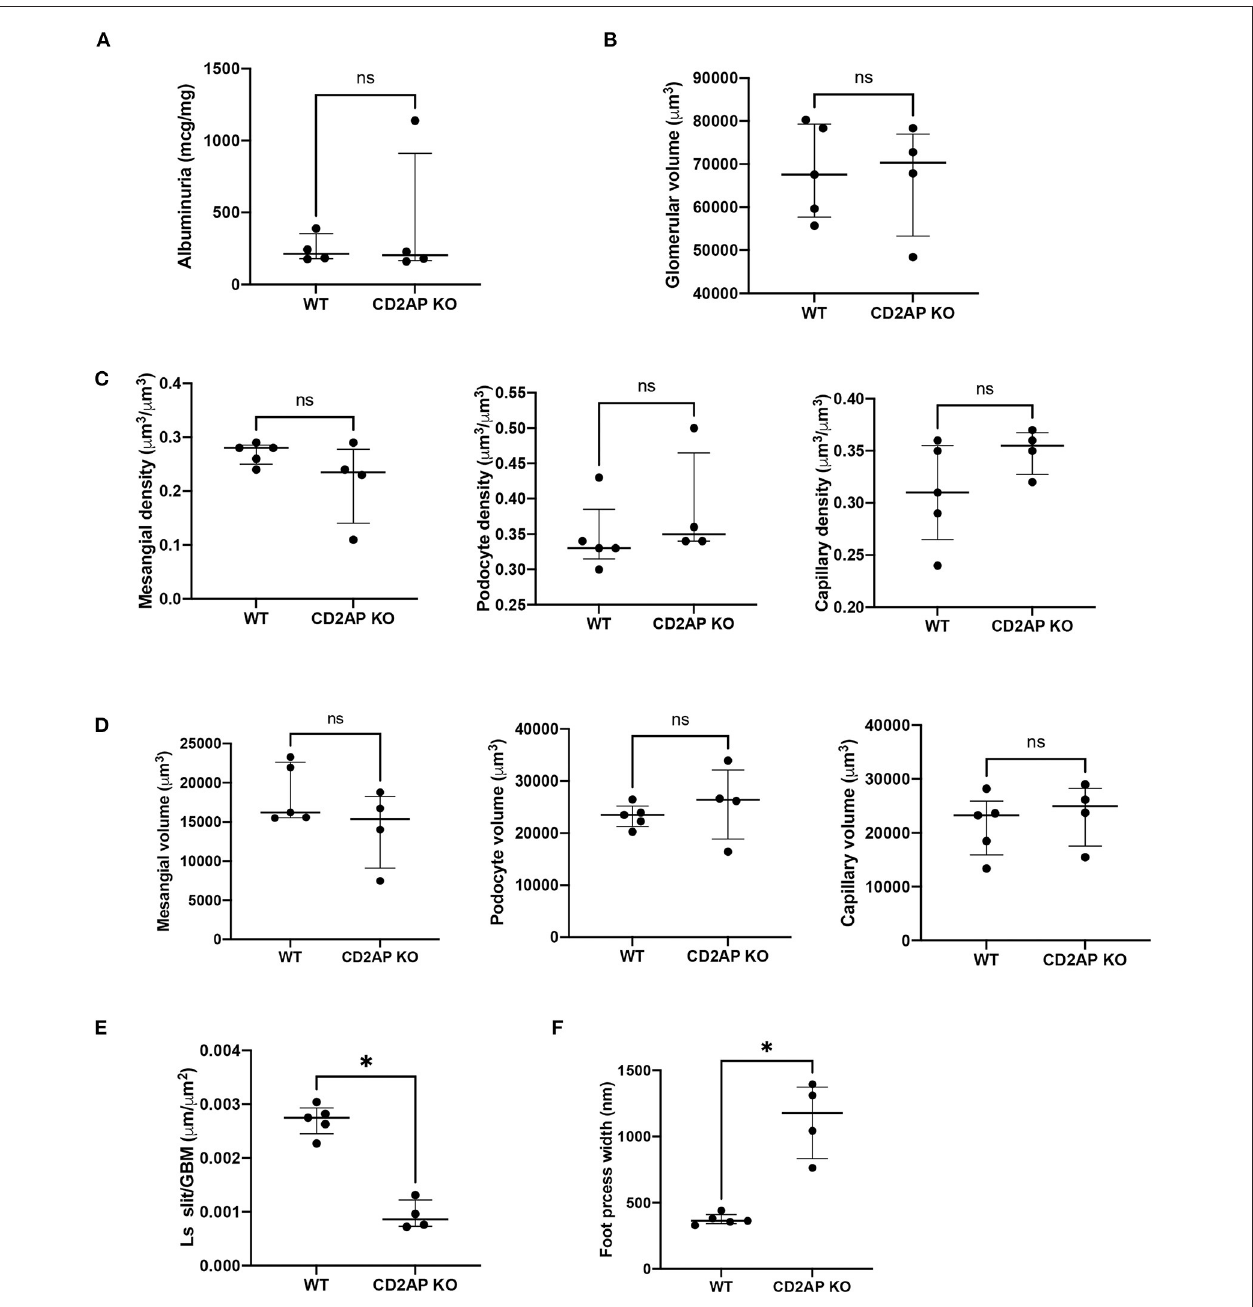
FIGURE 4 | Albuminuria and morphometric data. (A) Plot of albuminuria showing no difference between WT and CD2AP KO groups. (B) Plot of glomerular volumes showing no difference between WT and CD2AP KO groups. (C) Plot of glomerular component volume densities showing no difference between WT and CD2AP KO groups for mesangium, podocyte or capillary lumen. (D) Plot of glomerular component volumes showing no difference between WT and CD2AP KO groups for mesangium, podocyte or capillary lumen. (E) Plot of length density per GBM area of the slit diaphragm showing a statistical difference between WT and CD2AP KO groups. (F) Plot of foot process width showing a statistical difference between WT and CD2AP KO groups. * p =